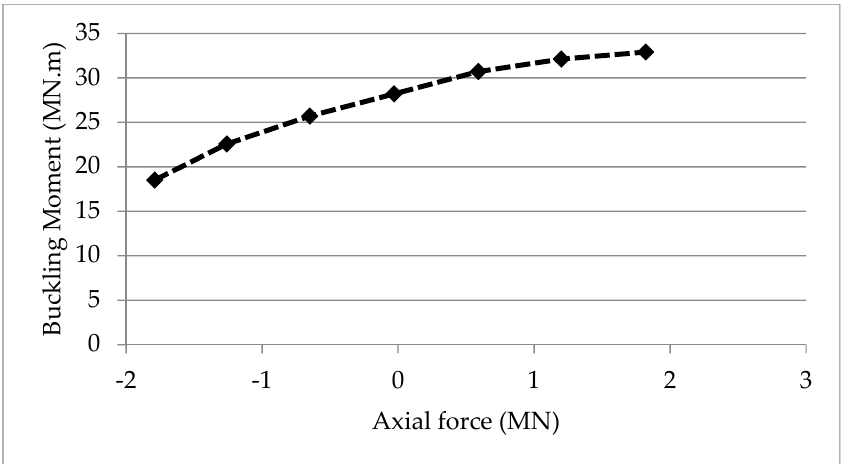
Figure 5. Buckling analysis for three-layer FML cantilevered beam using 5-element DFE.